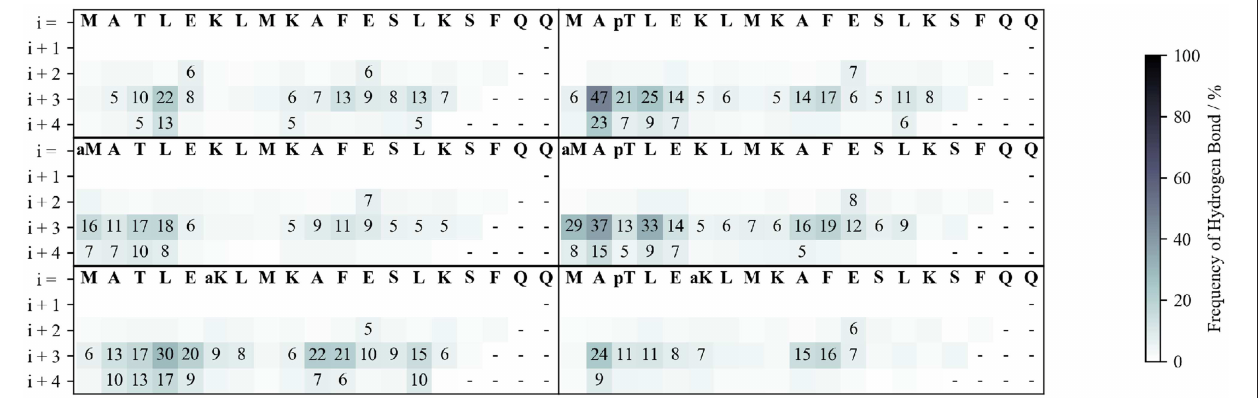
( Figure 2 ). The latter observation indicates that the interaction between pThr3 and Lys6 ε -amino group is key in the mechanism of helix stabilization by phosphorylation (Chiki et al.,